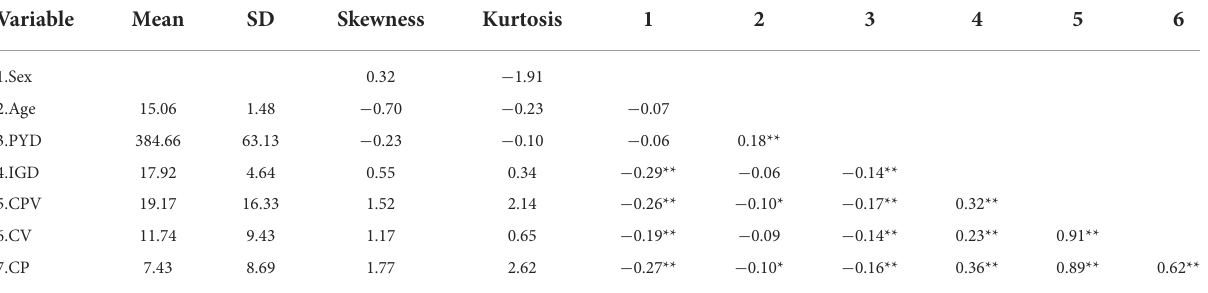
TABLE 1 Descriptive statistics and correlations of main variables. Variable